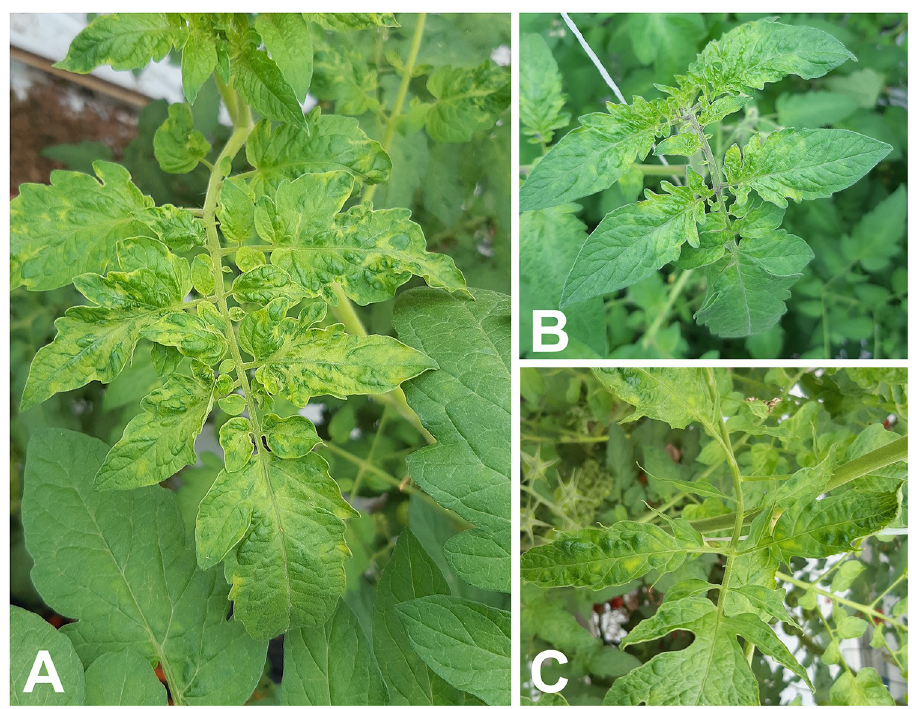
Fig 1. Symptoms observed during phytosanitary inspections. A Chlorotic mosaic on young leaves of ToBRFV and pepino mosaic virus infected tomato plants; B Chlorotic mottle on leaf bases of young leaves; and C narrowing of and chlorotic mottle on young